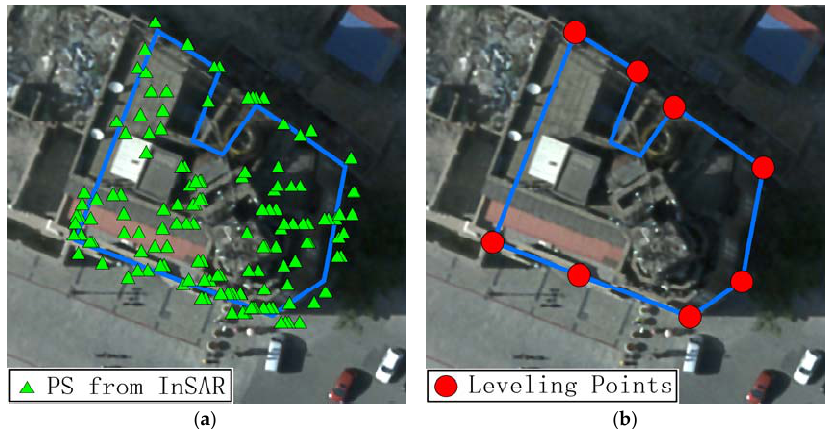
Figure 8. Spatial Diversity between InSAR and leveling in the Bohai Building with aerial ortho-photo of 0.2 m as background: ( a ) more than one hundred PS were located whole building from the vertical view; and ( b ) eight Leveling Points were located on edges of the Bohai Building.